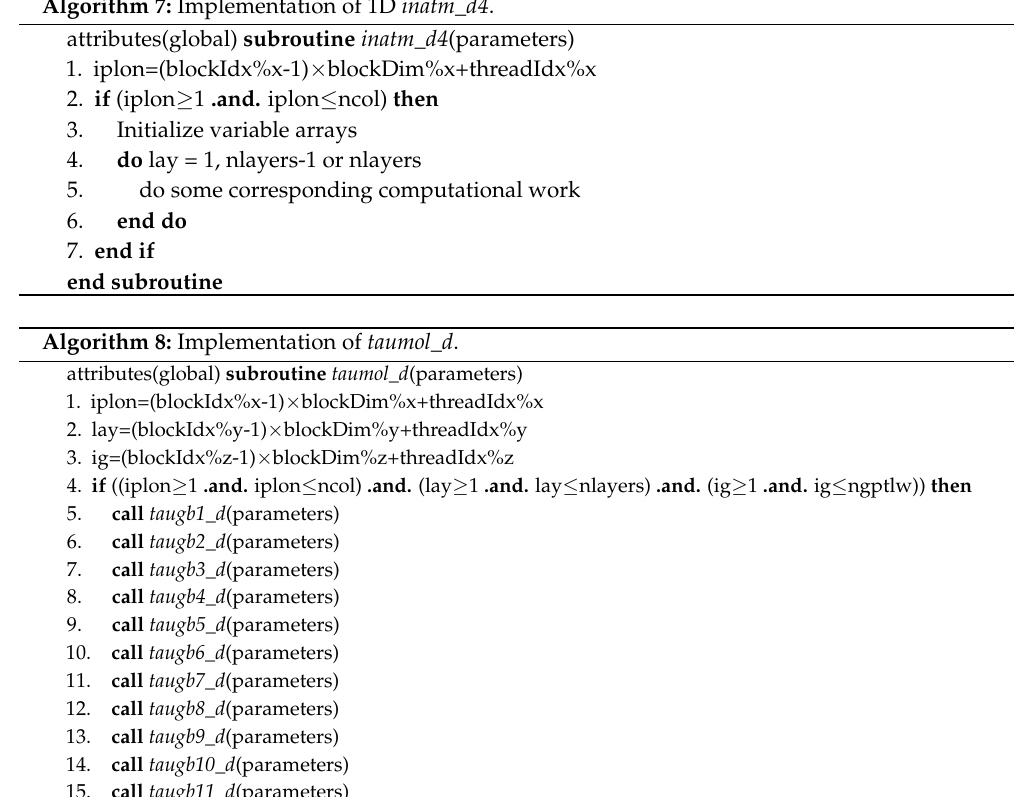
Algorithm 7: Implementation of 1D inatm_d4 .